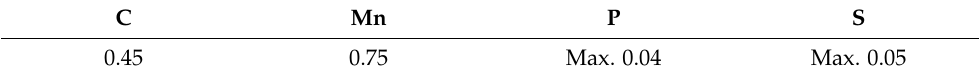
Table A3. Chemical composition of AISI 1045 (DIN C45) in mass % (provided by the